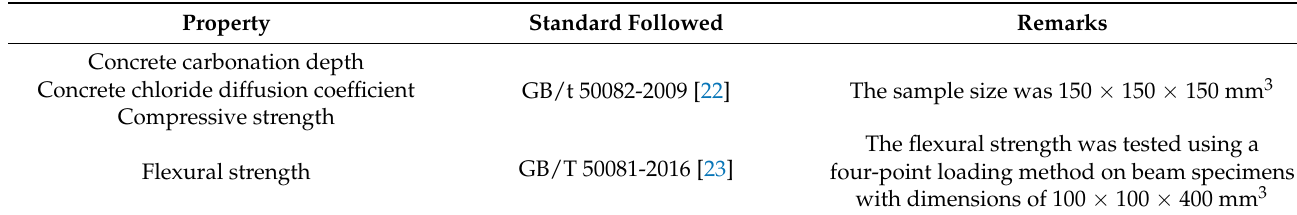
Table 3. Test program and relevant standards.